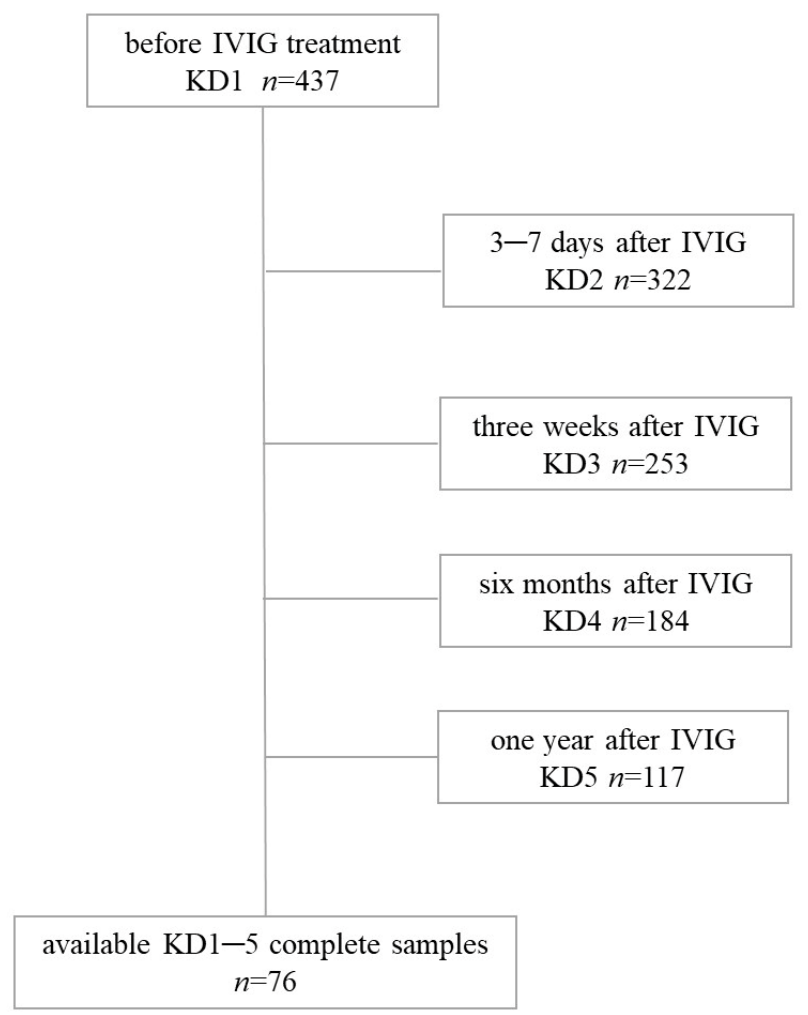
Figure 1. Flowchart of patients with Kawasaki disease. KD, Kawasaki disease; IVIG, intravenous immunoglobulin.